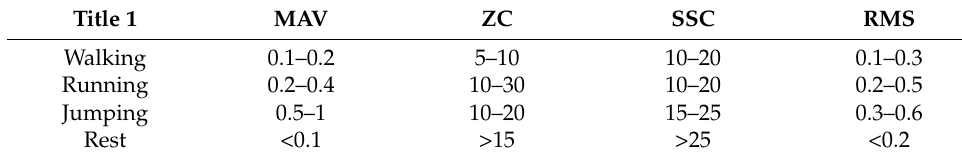
Table 4. EMG feature range for the discrimination of walking from rest